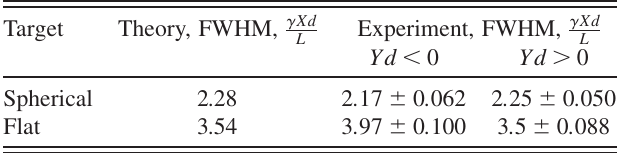
TABLE II. Estimated and experimental values of the FWHM of OTR angular distribution peaks.